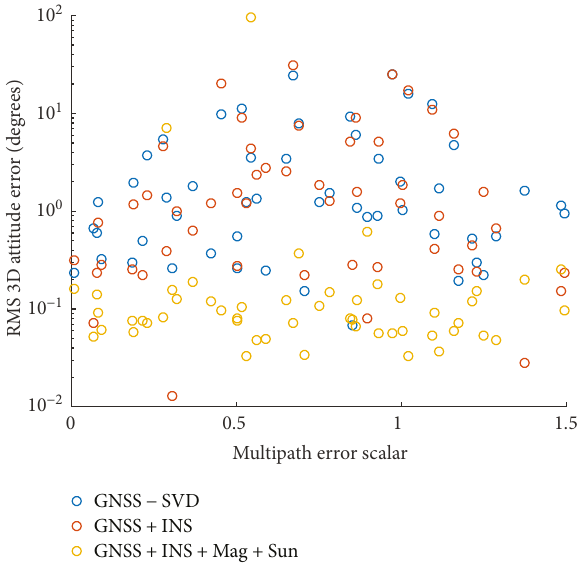
Figure 11: RMS attitude versus multipath error scale factor for each trial.